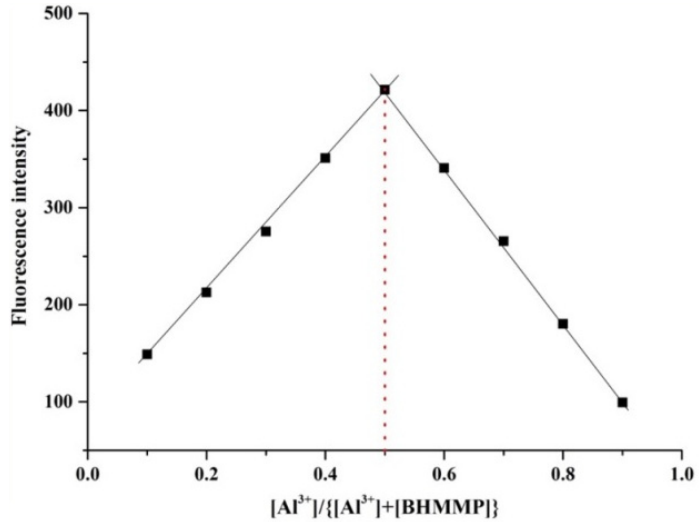
Figure 4. Job plot for evaluating the stoichiometry of BHMMP and Al 3+ with fluorescence spectra ( λ ex =370 nm, λ em =522 nm).